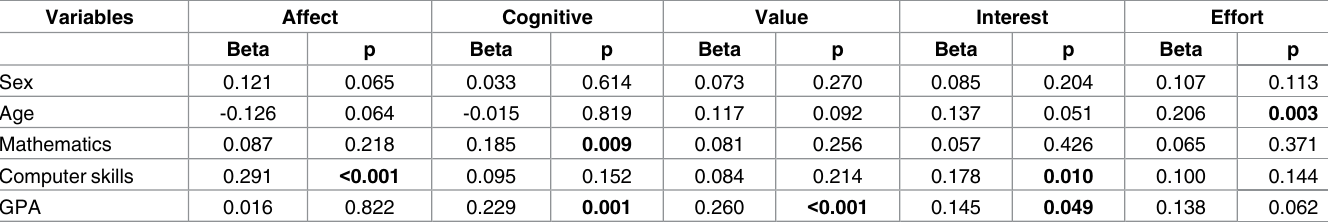
Table 2. Regression models of variables associated with student attitudes towards statistics (n = 461).